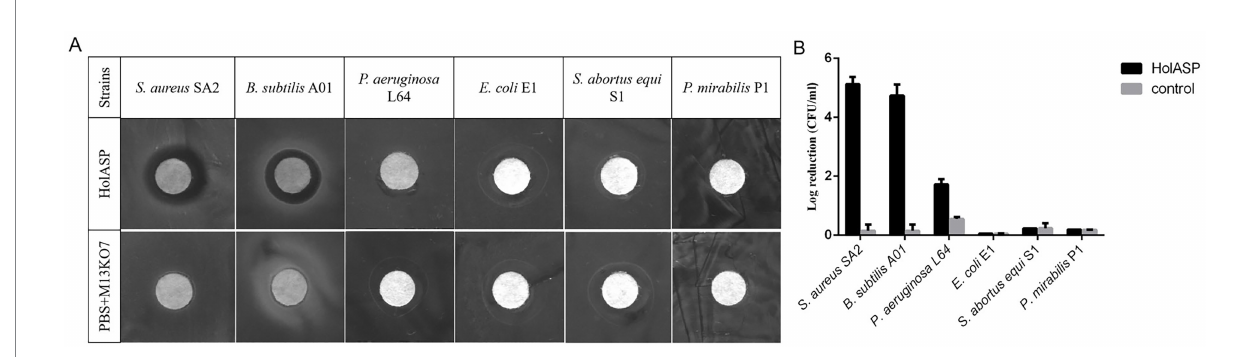
FIGURE 6 The antibacterial activity of recombinant phage HolASP. (A) Images of plaques formed on the lawns of different species of bacteria produced by HolASP. Plate lytic assay. The antibacterial activity of HolASP (10 8 virions/mL) against different species of bacteria was tested using plate assays. The mixed solution of PBS and M13KO7 was used as a negative control. (B) Antibacterial activity of HolASP against different species of bacteria. The bacterial suspension (5 × 10 7 CFU/mL) were exposed to HolASP (10 8 virions/mL) at 37 ° C for 12 h. Antibacterial activity in vitro was expressed as CFU reduction. The bacterial suspension without treatment with HolASP was used as control. Data are represented as mean ± SD ( n = 3). CFU, colony- forming unit; SD, standard